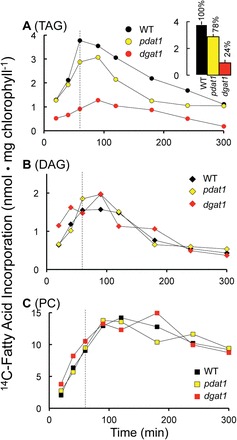
Synthesis and turnover of triacylglycerol in leaves of the wild type (WT) and dgat1 and pdat1 mutants. Incorporation of [14C]fatty acids into triacylglycerols (A), diacylglycerol (B), and phosphatidylcholine (C) in Arabidopsis WT and pdat1 and dgat1 mutants. The dotted line represents the end of the pulse period and the beginning of the chase period. The inset graph presents the percentage of WT incorporation after 60min of labelling. The data represent the average of three biological replicates. Additional data including all identified glycerolipids and free fatty acids with error bars are presented in Supplementar Fig. S2 at JXB online. (Figure 1 is available in colour at JXB online.)